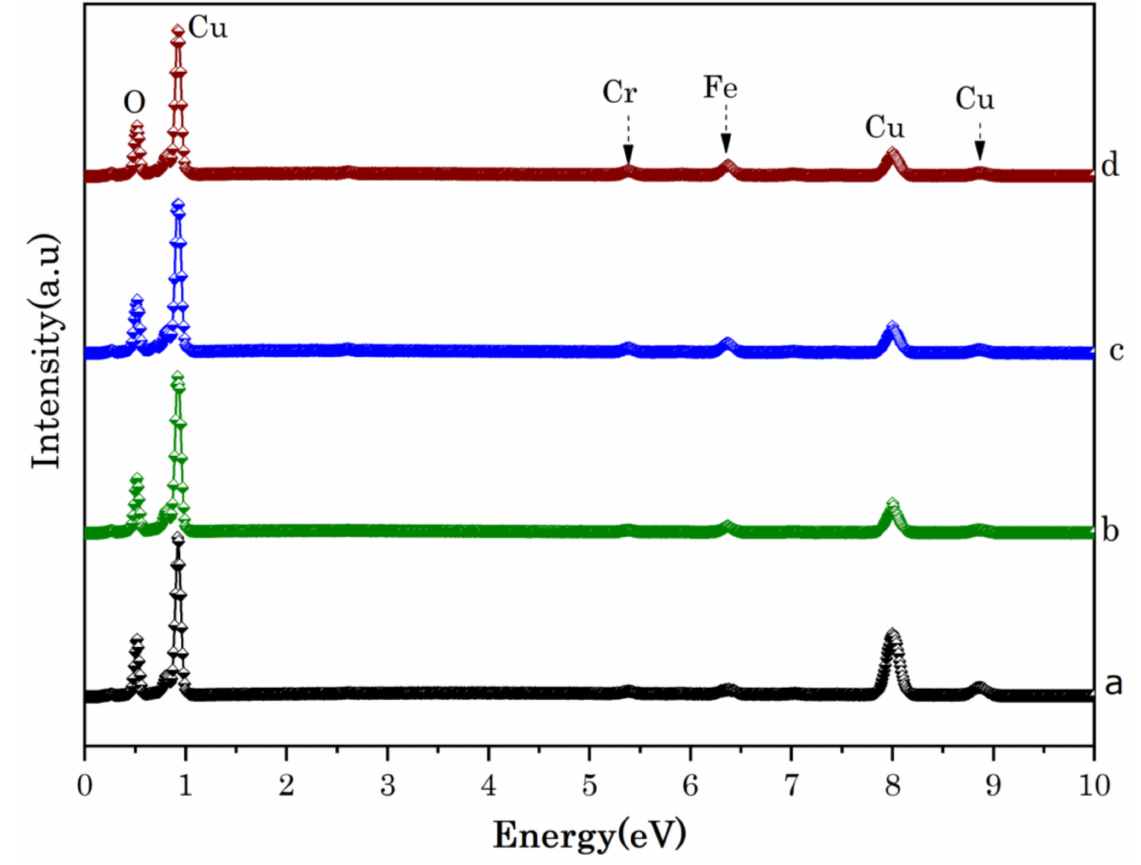
Figure 6. EDX spectra of CuO ( a ) 700 rpm, ( b ) 800 rpm, ( c ) 900 rpm, and ( d ) 1000